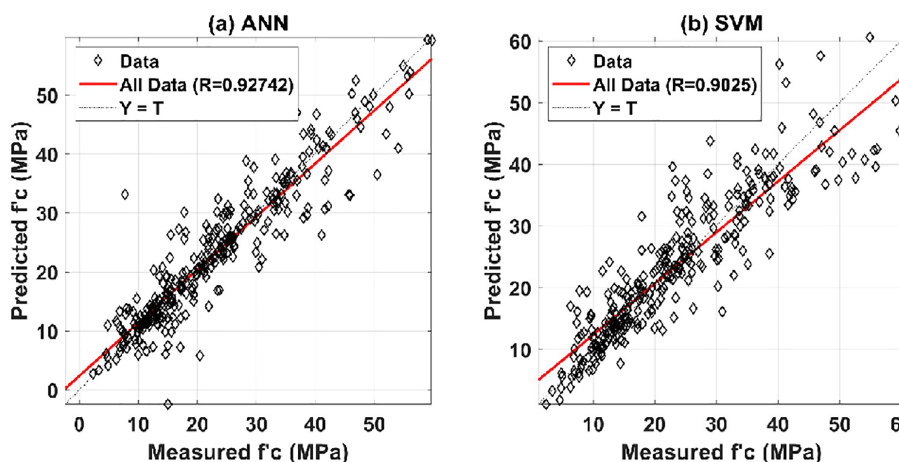
Fig 4. Regression graphs for the measured and predicted values of early compressive strength of HPC for all dataset: (a) ANN; and (b) SVM.